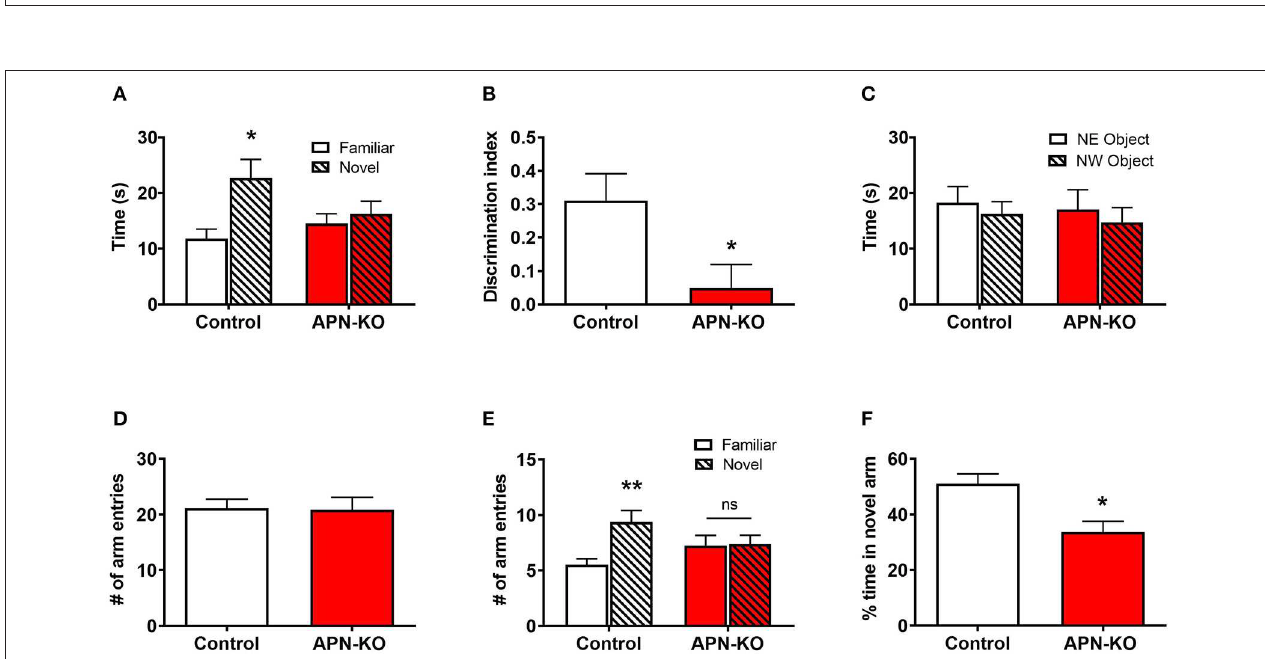
FIGURE 2 | APN-KO mice display deficits in novel object recognition test and in two-trial Y-maze. (A) Time spent interacting with the familiar vs. novel object during testing. (B) Discrimination index calculated as (T N – T F )/(T N + T F ) where T N is time spent with the novel object and T F is time spent with the familiar object. (C) Time spent interacting with the object in the northeast (NE) and northwest (NW) quadrants during familiarization. (D) Total number of arm entries during testing (E) number of arm entries into the familiar and novel arms during testing (F) percent time spent in novel arm during testing. Bars represent mean ± SEM; * p < 0.05, ** p < 0.01; n = 8 mice per